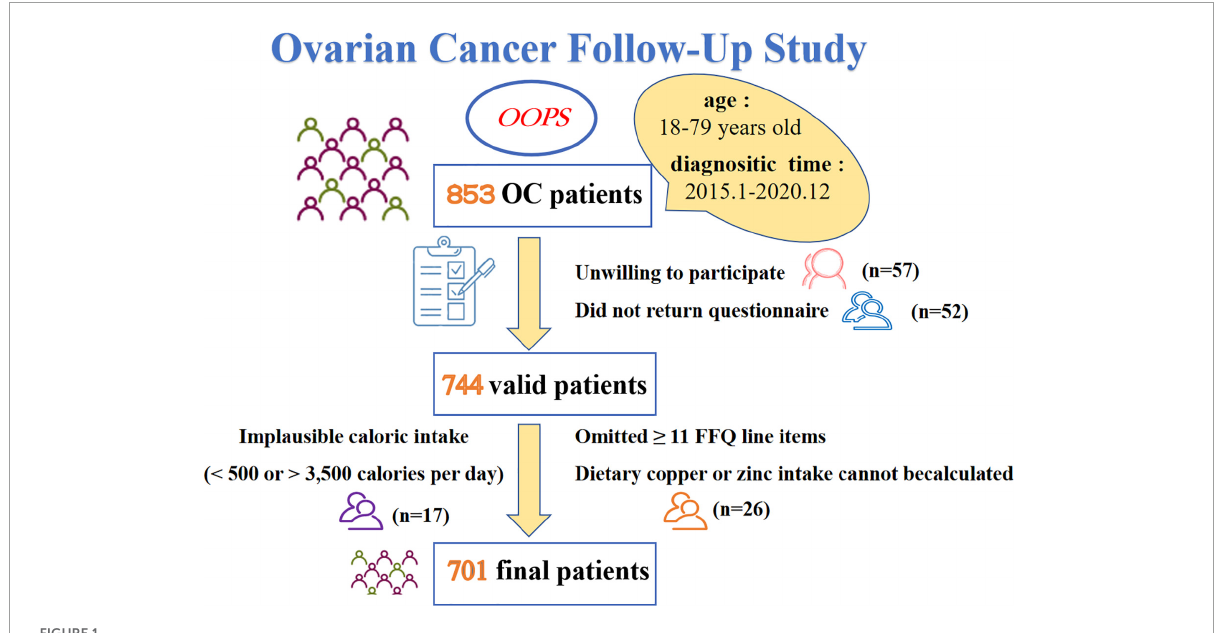
FIGURE1 Flow chart of participants through